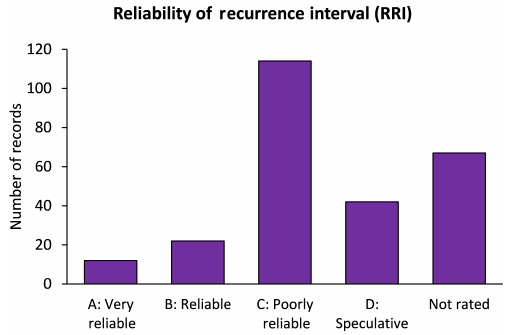
Figure 5. Distribution of rating levels for the database field relia- bility of the maximum magnitude estimation (RMM) in QAFI v.3 database. See text for explanations.